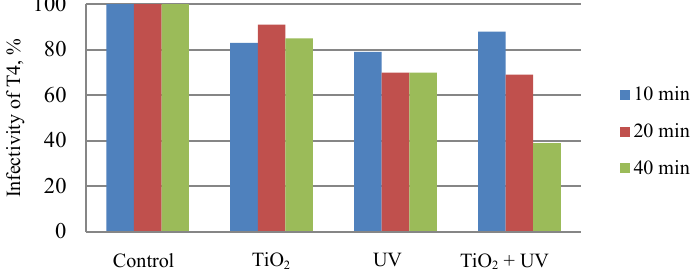
Fig. 1. Effects of treatment on infectivity of bacteriophage T4. The experiments were performed at 22 °C, the initial number of T4 was 1×10 4 pfu/mL, 1 mg/mL of TiO 2 and intensity of UV irradiation 2 mW/cm 2 were applied. Similar testing of the PRD1 phage (Fig. 2), revealed that this phage was far more sensitive (100 % infectivity reduction in 20 min) to the combined UV and TiO 2 photocatalytic treatment than bacteriophage T4. In particular it can be noted that PRD1 was more sensitive to UV